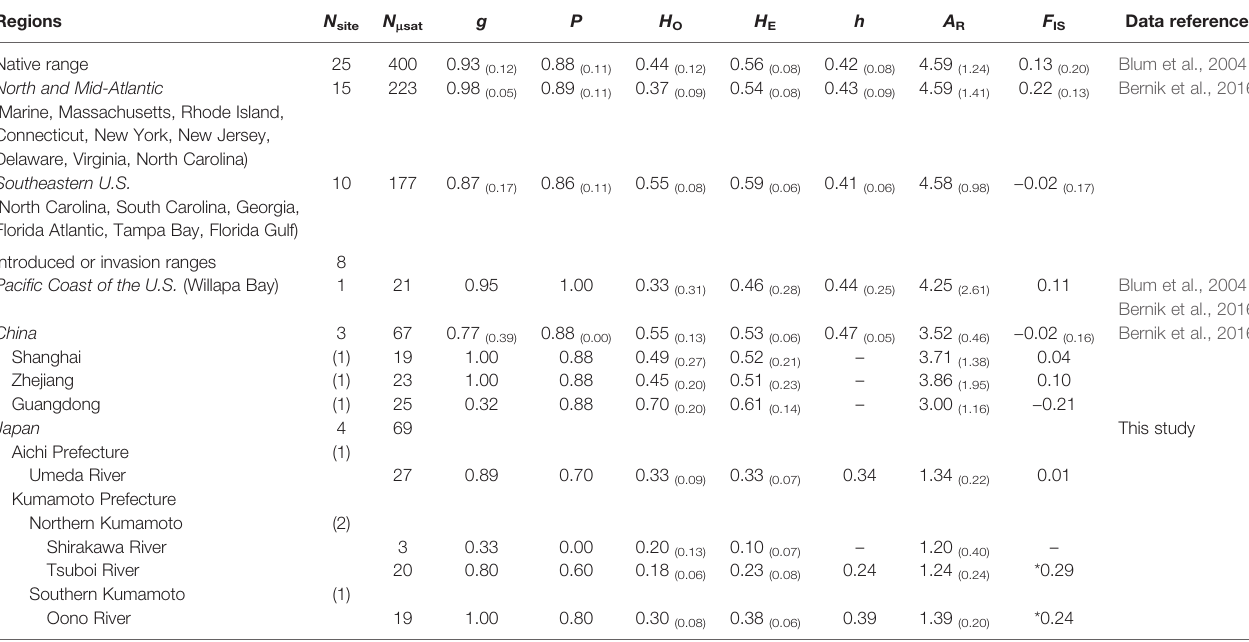
TABLE 1 | Information on the genetic diversity of invasive Spartina alterni fl ora based on the microsatellite loci in Japan. Regions